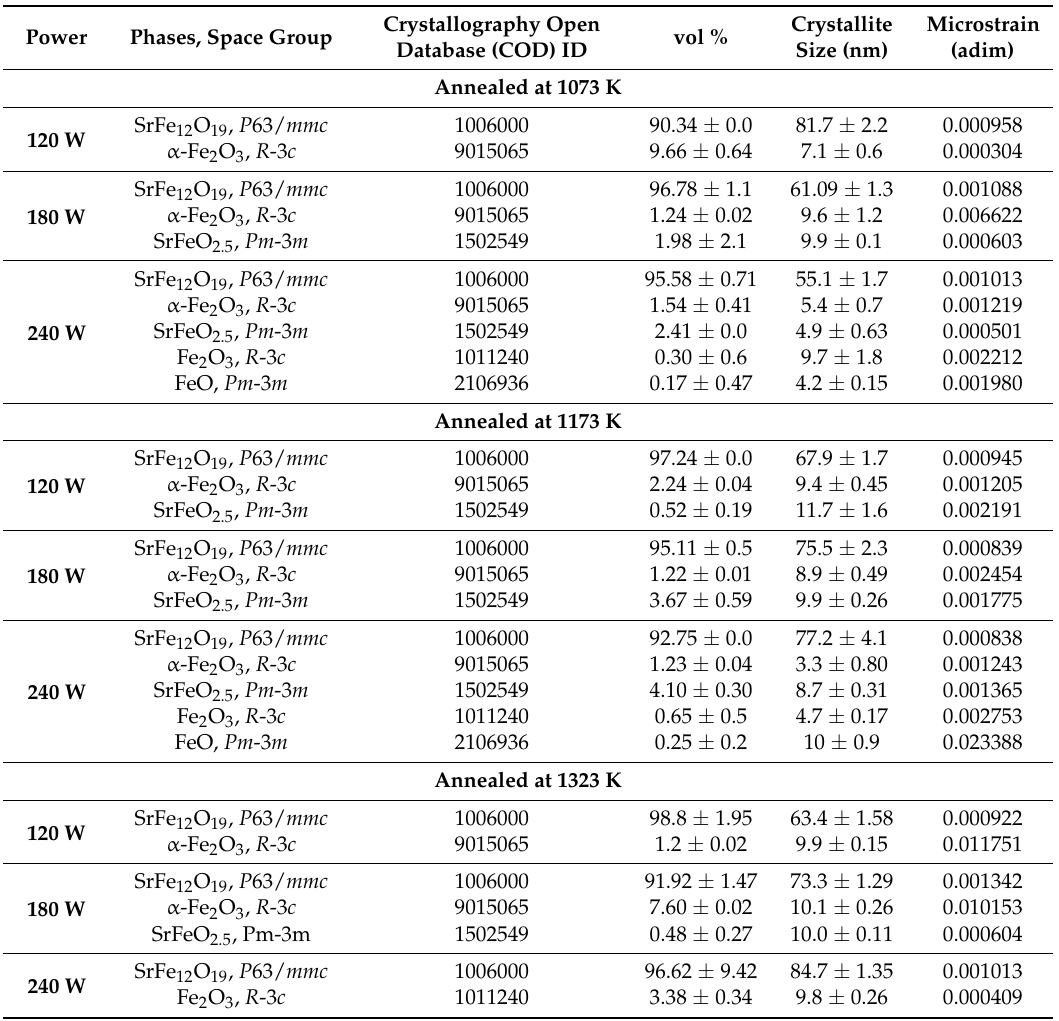
Table 2. Data from the Rietveld refinements of the XRD patterns of the powders obtained at 120, 180, and 240 W with heat treatment at 1073, 1173, and 1323